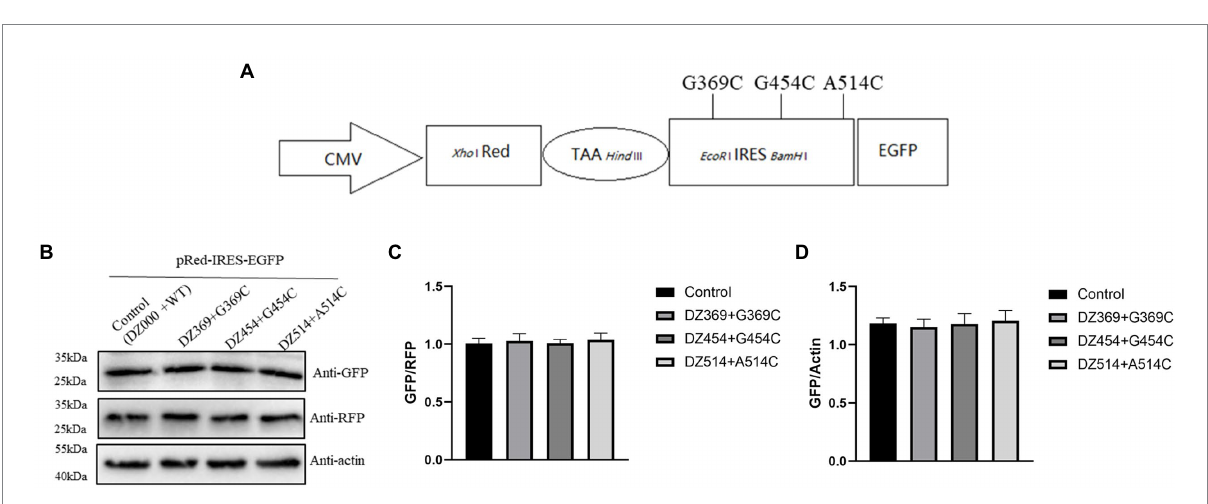
FIGURE 6 DNAzymes failed to inhibit the translation mediated by the 300–618 nt of DHAV-1 5 ′ UTR mutants. (A) Schematic representation showing the pRed-IRES-EGFP mutants. (B) pRed-IRES-EGFP mutant was cotransfected with DZ369, DZ454, DZ514 or DZ000 (as the control group) in DEFs, and cells were harvested 48 h later and analyzed by immunoblotting with the indicated antibodies. (C,D) Band intensity was quantified with ImageJ software, and RFP or β -actin was used as the mandatory control or loading control. The ratio of GFP to RFP or GFP to β -actin was normalized to the respective levels in the control